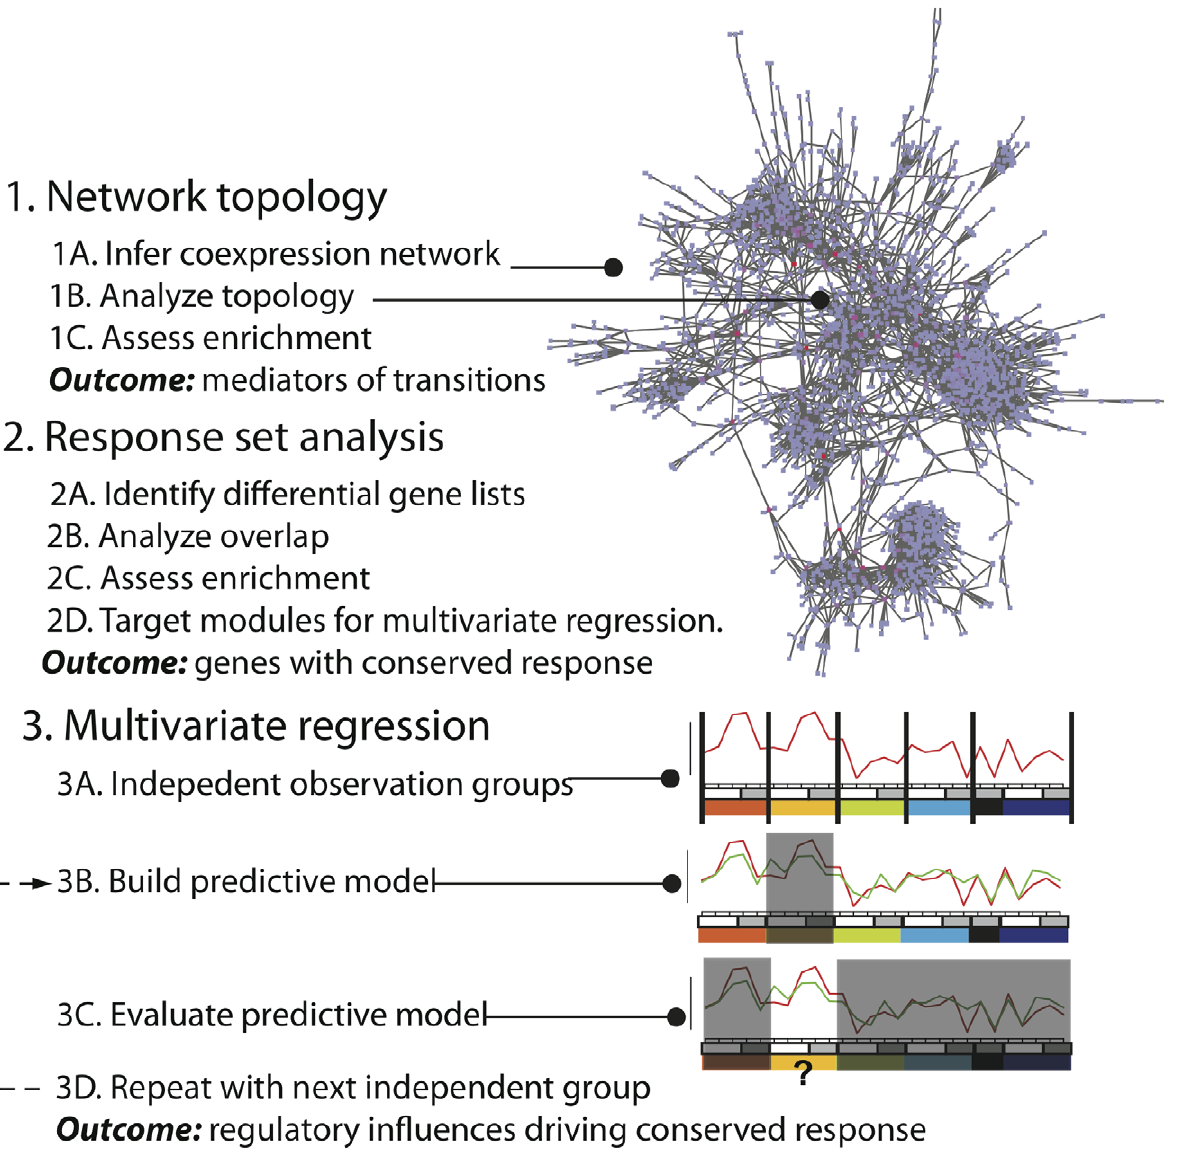
Figure 1. Overview of computational approaches.